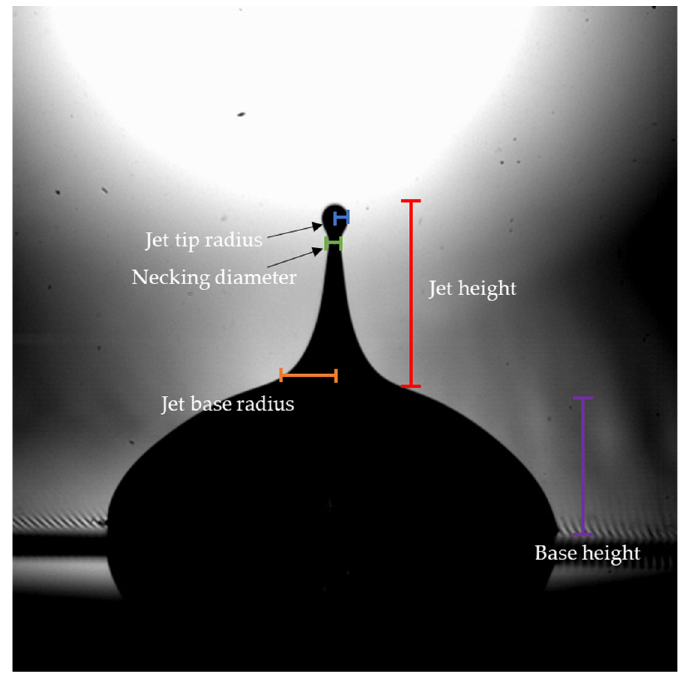
Figure 3. Image of jet dimensions that were extracted with labels.